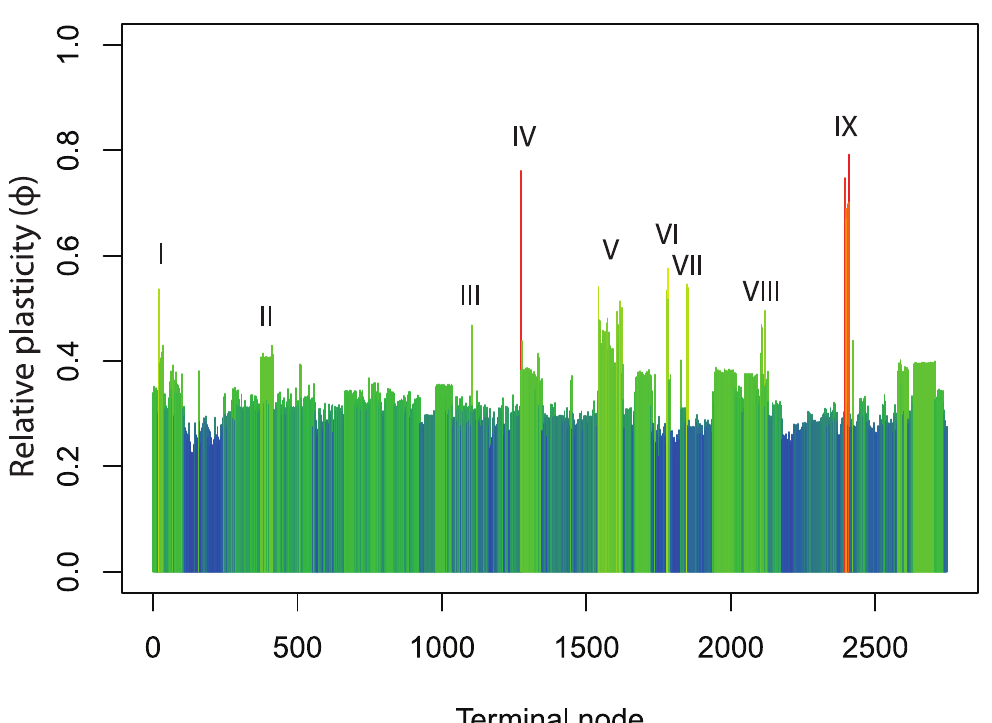
Fig 1. Relative genomic plasticity of the genomes used for metabolic inference. Colors correspond to the level of plasticity, which is also given by the y- axis. X-axis is labeled according to terminal node order for the representative 16S rRNA gene from each genome on a phylogenetic tree rooted at the node ancestral to the Archaea and Planctomyces (S1 File). Note that terminal node order on this rooted tree does not correspond to edge numbers on the unrooted tree used for phylogenetic placement (S2 File). Arrows indicate strains or clades with exceptional plasticity, the majority of which are known symbionts. I) Nanoarcheum equitans II) the Mycobacteria III) a butyrate producing bacterium within the Clostridium IV) Candidatus Hodgkinia circadicola V) the Mycoplasma VI) Sulcia muelleri VII) Portiera aleyrodidanum VIII) Buchnera aphidicola , IX) the Oxalobacteraceae